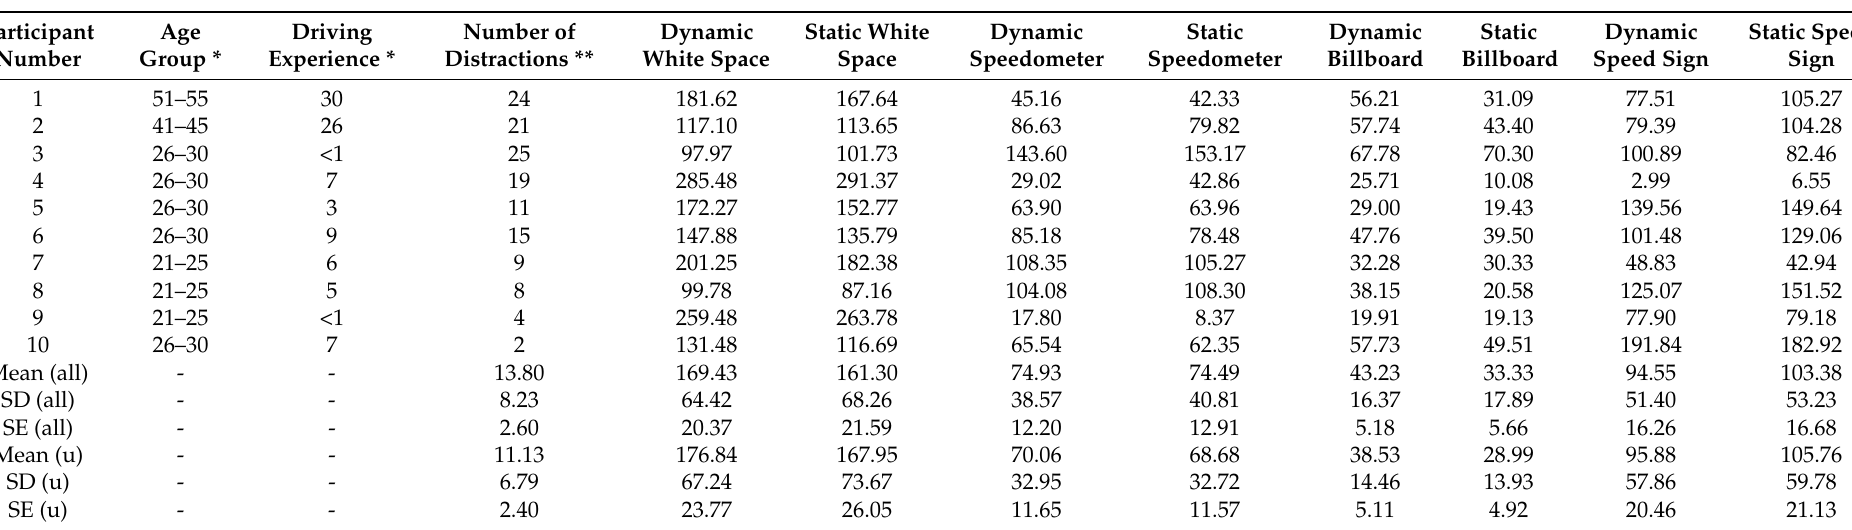
Table 3. Eye gaze fixation duration (seconds) of each individual participant, from approximately 15 s before the car driving pass by the billboards. Fixations are measured between static billboards and dynamic billboards across four AOIs, white space, speedometer, billboard, and speed